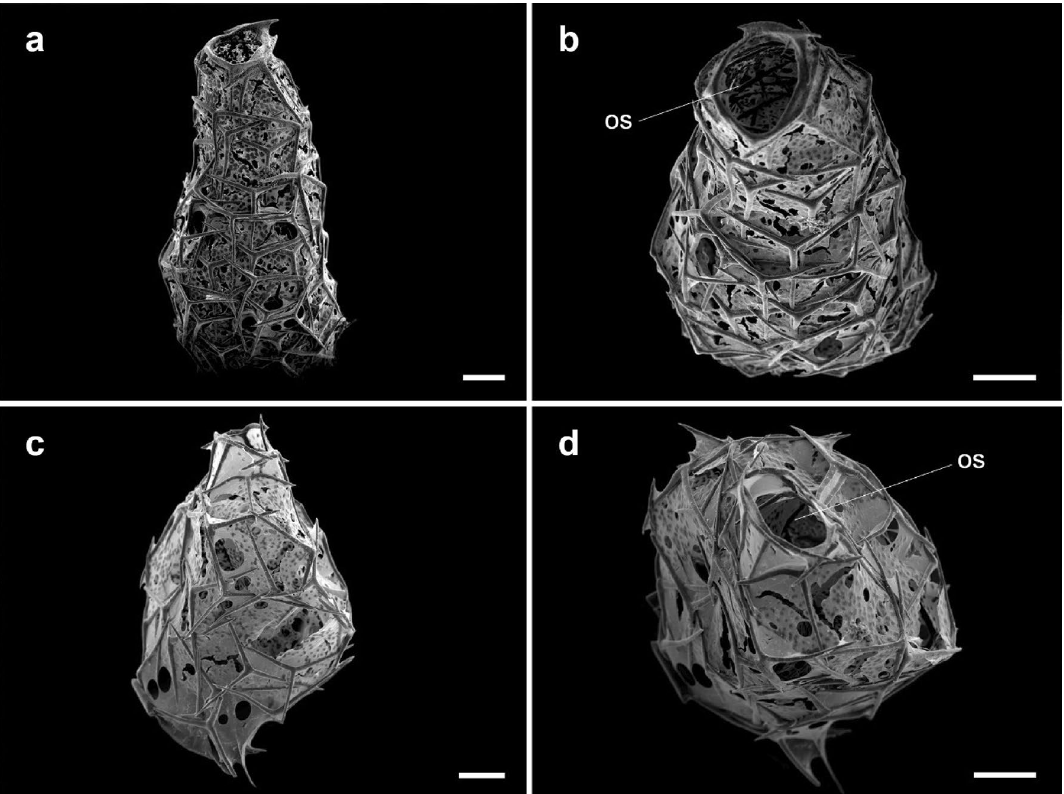
Figure 1. Sponges developed from the primmorphs of the calcareous sponge Paraleucilla magna in the experimental system, SEM images. ( a , b ) control; ( c , d ) low pH. Scale bars = 50 µm. os